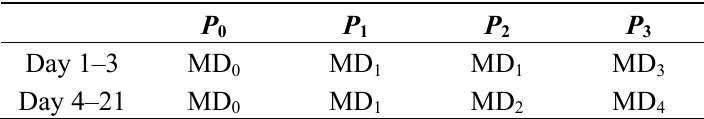
Table 2. Timeline describing the administration of P induced